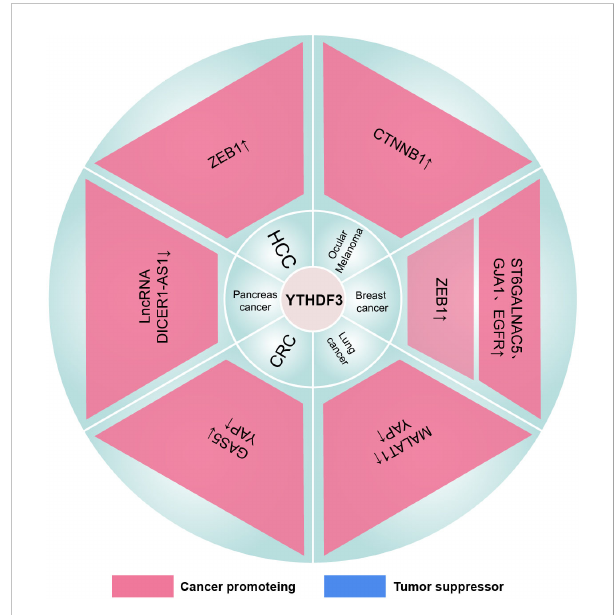
FIGURE 6 The mechanism of the YTHDF3 family in cancers. “ ↓ ” is the decrease of target mRNAs. “ ↑ ” is the increase of target mRNAs.